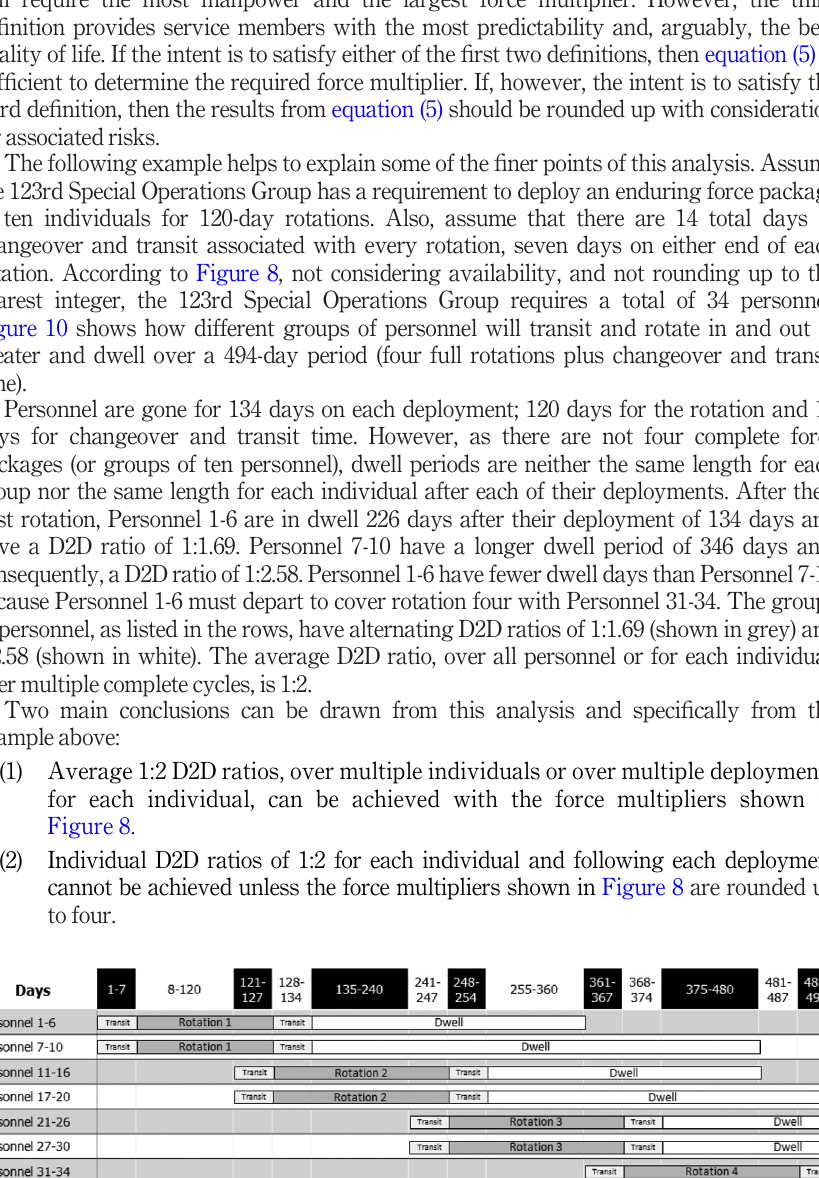
Figure 10. Example: 123rd special operations group changeover, transit, rotation, and dwell